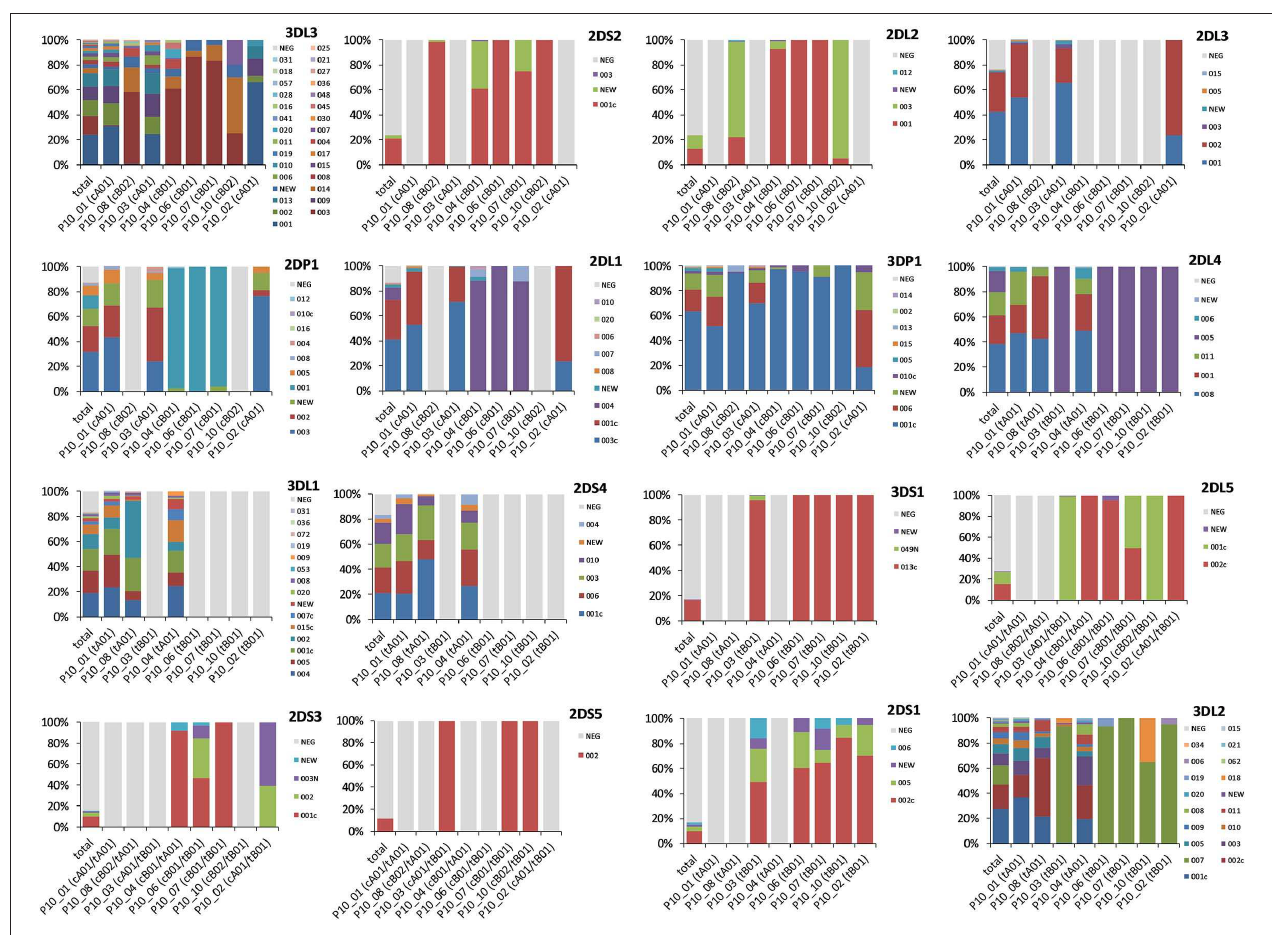
FIGURE 3 | Allele group frequencies per KIR gene. Displayed are, for each of the 16 KIR genes, the allele frequencies for the estimated allele group KIR HF overall (total) and for the 8 CNPS haplotypes with a frequency of f ≥ 1%. The proportion of absence of the respective gene is indicated as “NEG” in light gray. The centromeric or telomeric haplotype structure of the respective CNPS haplotypes in A/B haplotype nomenclature according to Pyo et al. ( 48, 50) is indicated in brackets in the labeling of the diagram